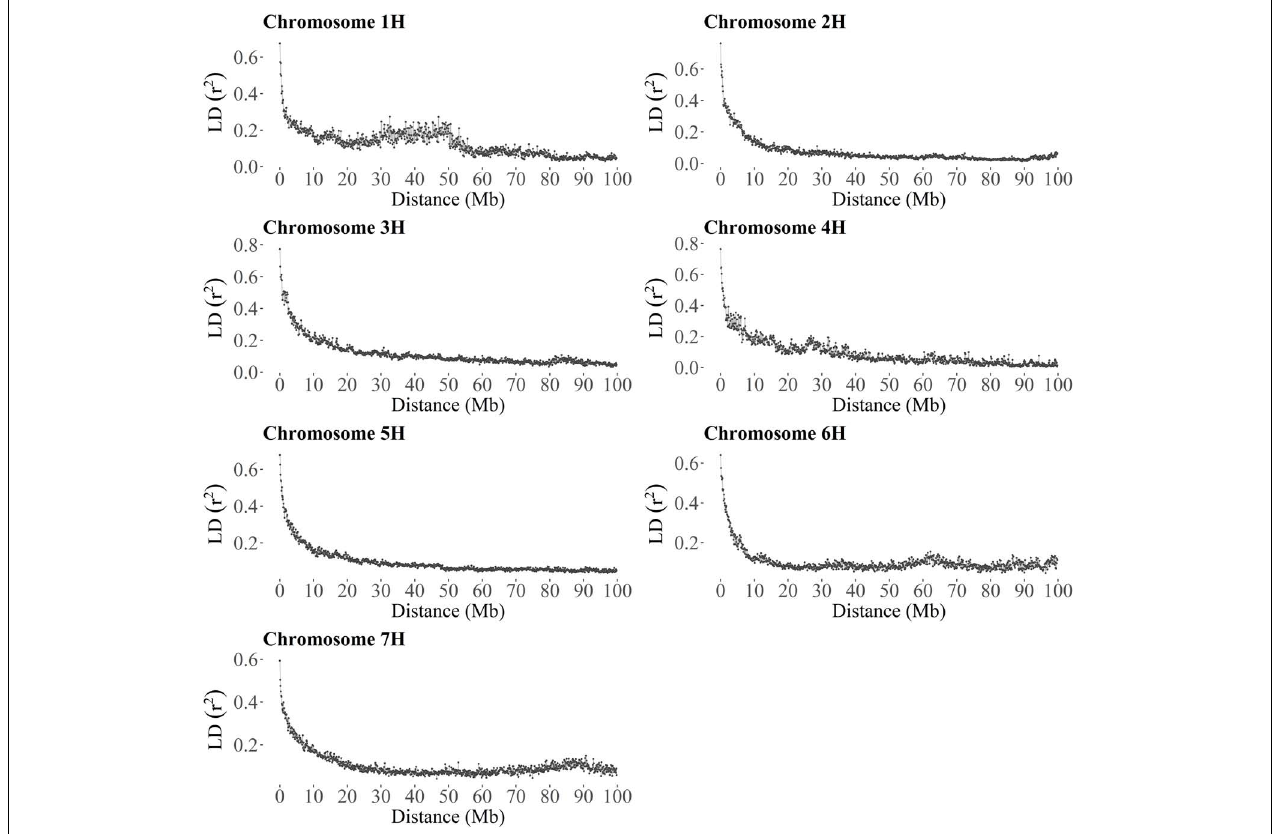
FIGURE 4 | Extent of the average linkage disequilibrium in TP-Diverse. For each barley chromosome, each point shows the average r 2 computed in 100 kb windows as a function of marker distance. TABLE 3 | Summary of field trials carried out for phenotyping TP and VP for GY. Acronym Site Country Growing